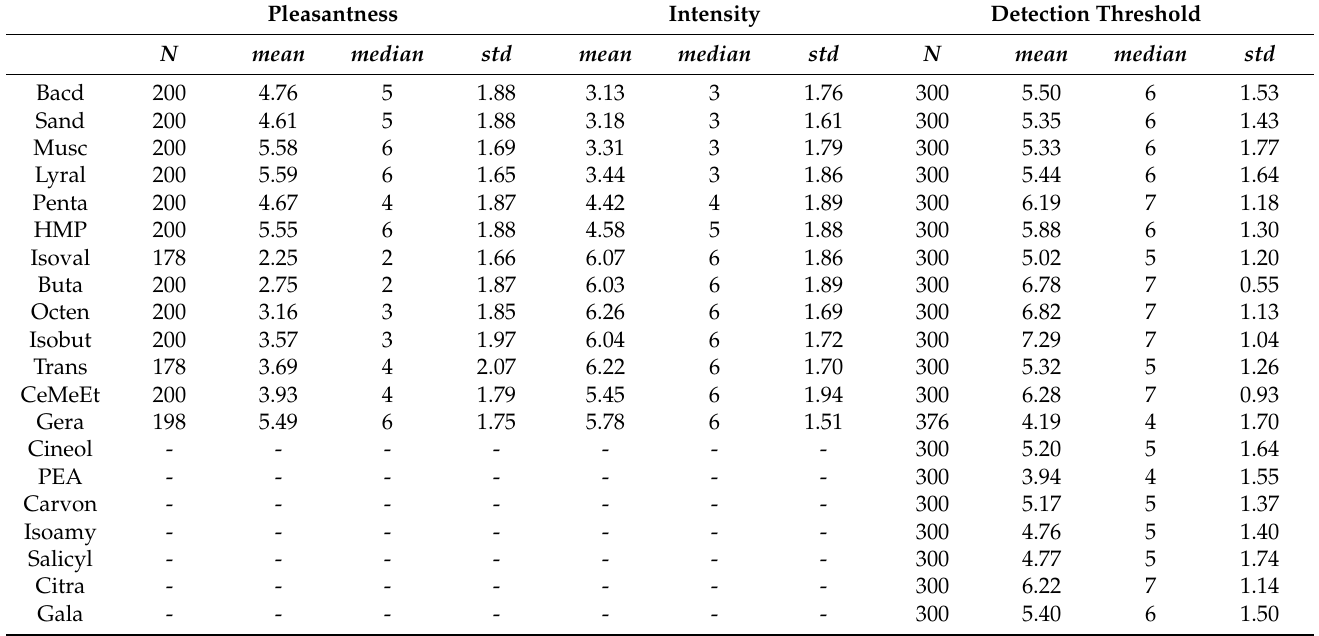
Table 3. Descriptive Statistics for Detection Threshold and Pleasantness and Intensity Ratings. Pleasantness